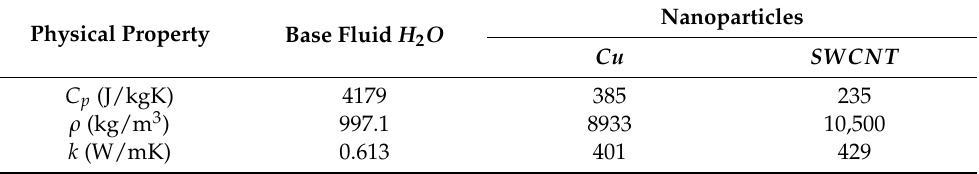
Table 1. Thermophysical properties of the base fluid water and the two kinds of nanoparticles [10,32]. Physical